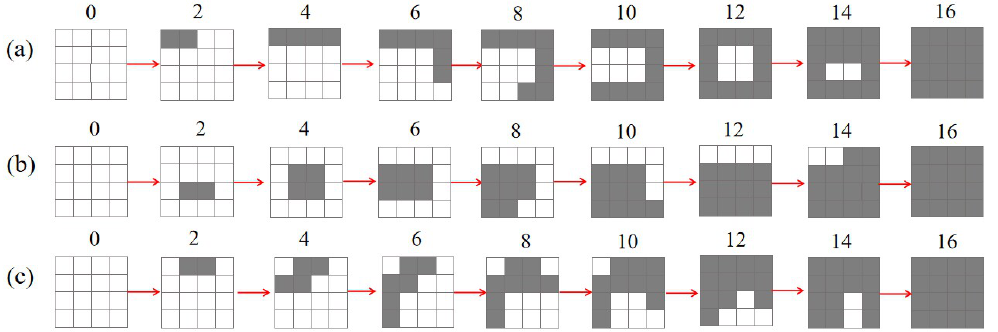
Figure 3. The process of ( a ) the first method, ( b ) the second method, and ( c ) the third method for increasing the number of glass elements.